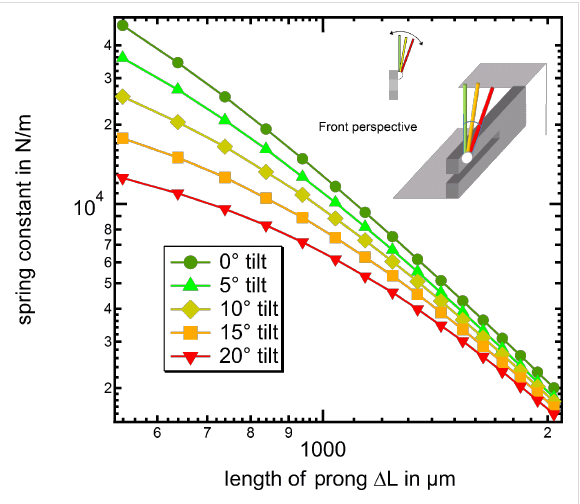
Figure 9: FEM simulation result displaying the influence of a tilted tungsten wire on the resulting spring constant versus a non tilted wire. It is obvious that a strongly tilted tip causes an increasing influence of torsion. Thus during the assembly one should also focus on the angle between tuning fork and wire trying to keep it as small as